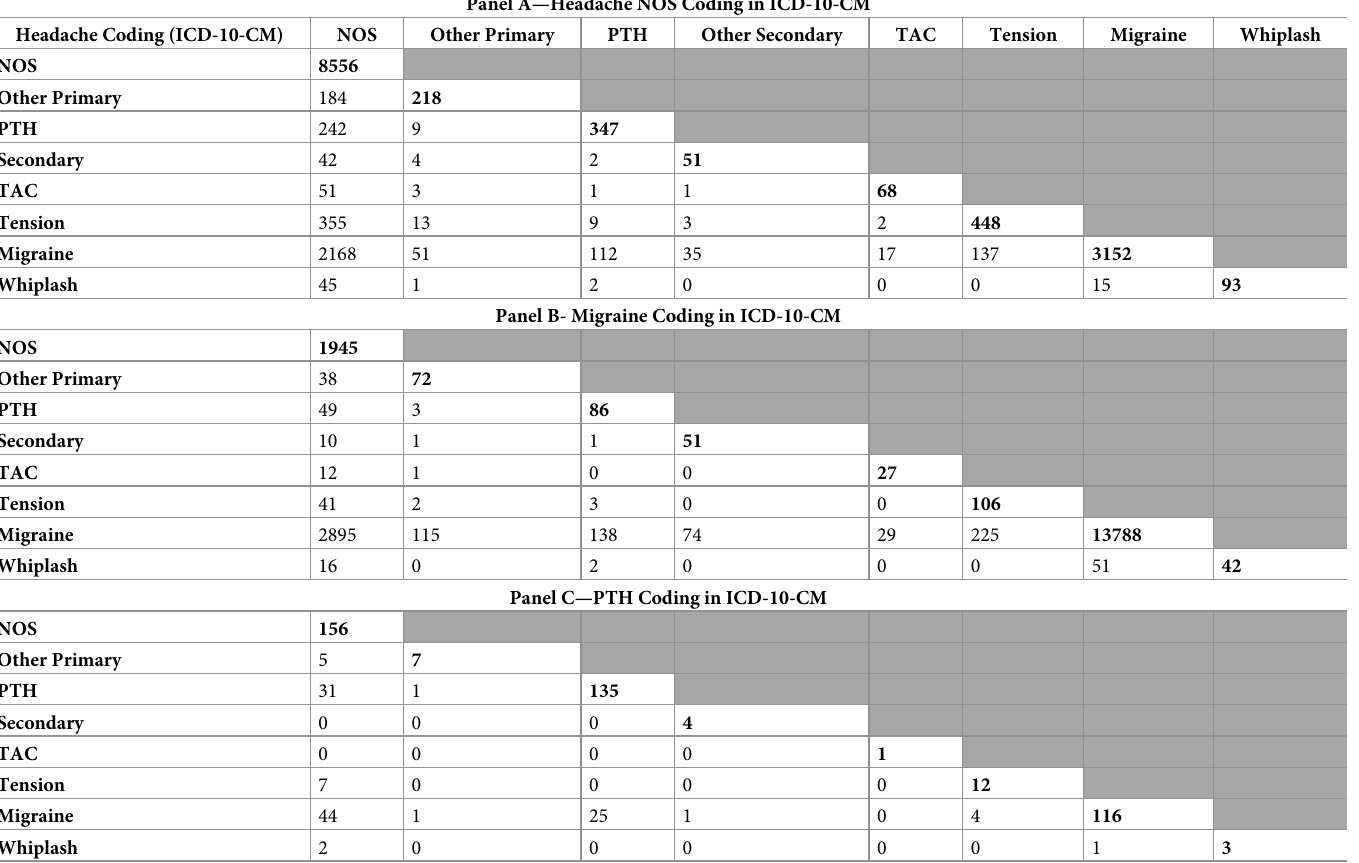
headache diagnosis (Table 2, Panel A). About 20% (3,504/17,307) of patients had two headache diagnoses with the remaining 5% (870/17,307) receiving three or more distinct headache codes (Fig 1, Panle A). The prevalence of ICD-10-CM diagnoses for patients with ICD-9-CM coded headache NOS were: headache NOS (49%; 8,556/17,307), migraine (18%; 3,152/17,307), and tension-type headache (3%; 448/17,307; see Table 2 Panel A). In considering multiple diagnoses, approximately 13% (2,168/17,307) of patients carried the combination of headache NOS and migraine diagnoses compared to 2% (355/17,307) of patients who were coded as the combination of headache NOS and tension-type headache. Few patients with headache NOS received multiple specific headache diagnoses, including those receiving the combination of migraine and tension-type headache (0.8%; 137/17,307) and migraine and PTH (0.6%; 112/ 17,307). Fig 2 with Panels A, B, C shows a visual representation of the corresponding panels in Table 2. Both axes in a given panel refer to ICD-10-CM coding as this representation visualizes the details of ICD-10-CM coding in FY 2016/2017. However, each panel shows coding for patients with a certain headache based on ICD-9-CM in FY 2014/2015. For example, Panel A, shows the details of the ICD-10-CM coding for patients who were coded for NOS headache